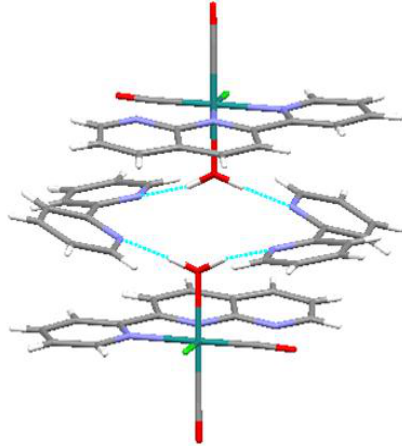
Figure 5. Intermolecular hydrogen bonds (blue dashed lines) in the crystal packing of the title compound.